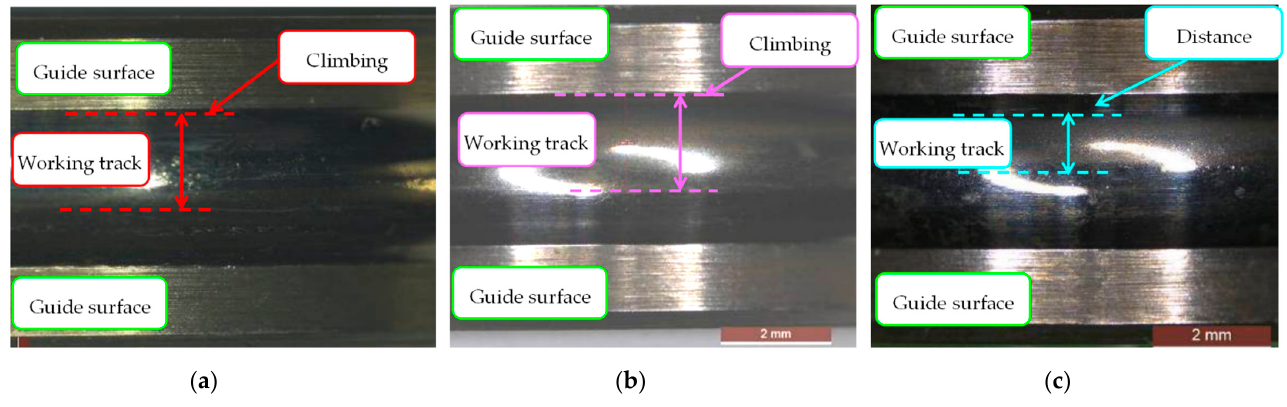
Figure 17. Comparison of the working tracks.( a )Working track of the outer ring raceway of the failure bearing; ( b )working track of the outer ring raceway of the test bearing corresponding to the faulty spring; ( c )working track of the outer ring raceway of the bearing corresponding to the normal spring.